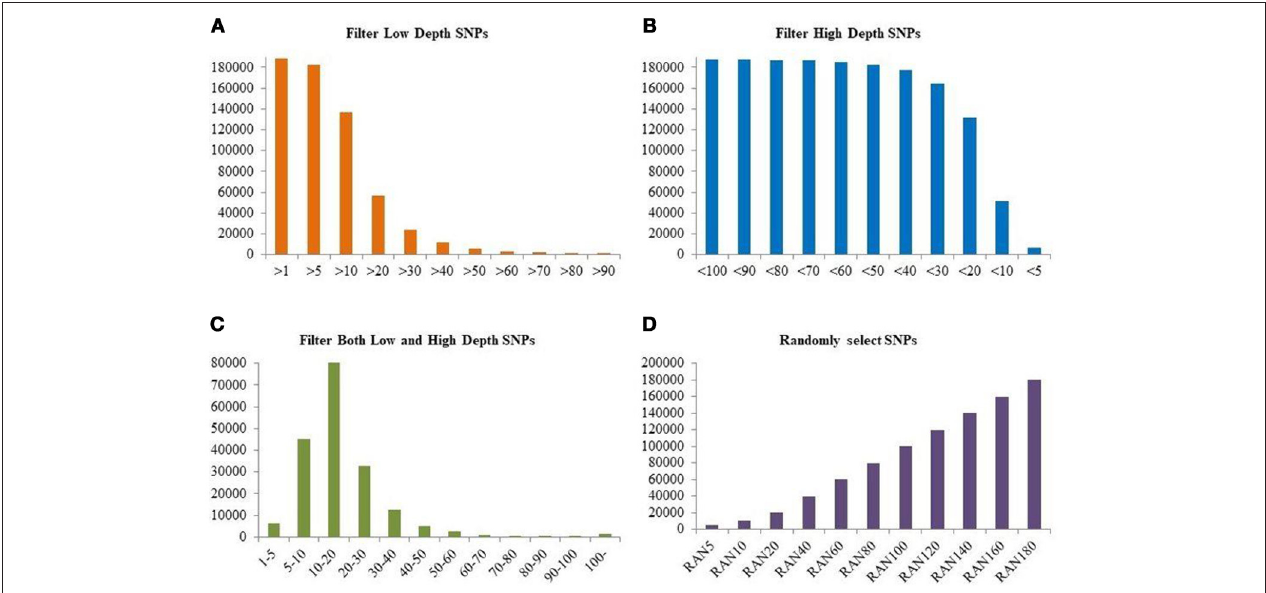
FIGURE 2 | Numbers of SNPs retained for four different filtering strategies. (A) Number of SNPs in each FILTLOW dataset with different lower threshold; (B) Number of SNPs in each FILTHIGH dataset with different upper threshold; (C) Number of SNPs in each FILTBOTH dataset with different lower and upper thresholds; (D) Number of SNPs in each RAN dataset with different size. The y-axis is the number of SNPs after filtering. In (A–C) , the x-axis is different subsets of SNPs with various sequencing depth, and the x-axis in (D) is randomly selected subset with different size.